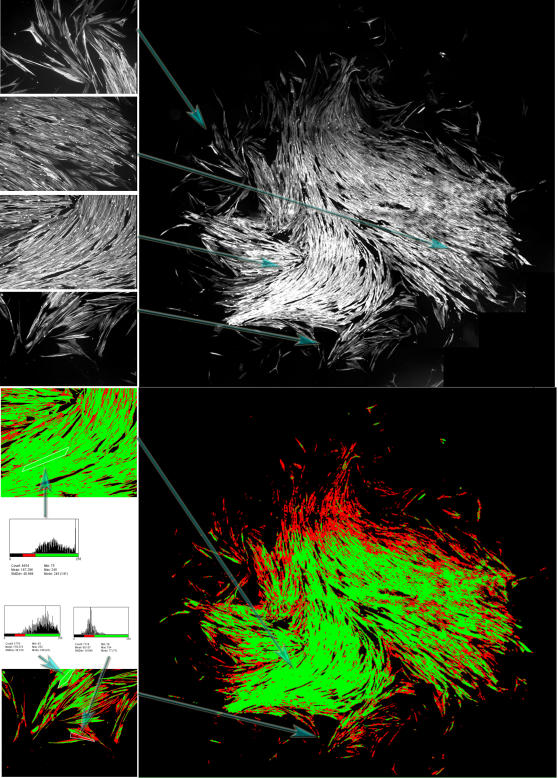
Clonal population derived from a human primary myoblast.
A: The cells were fixed and immunostained with an anti-desmin antibody. A series of 55 pictures were obtained and compiled into a single picture showing the whole population. The variation in the intensity of desmin immunostain is higher at the periphery of the growing population. The left panel shows 4 high resolution images of different parts of the population pointed by the blue arrows. B: Colour coded image of the same population as on the A panel. The colour code is based on the intensity of the pixels (red: low, green: high intensity). On the left are shown 2 high resolution images with the same color code. In the upper left, a region of interest is indicated in white with the corresponding pixel histogram shown beneath. Two additional histograms show the pixel intensities of two regions of interest: high-(green) and a low-desmin expressing cells (red). Note that the low desmin expressing cells are more frequent at the periphery of the culture.